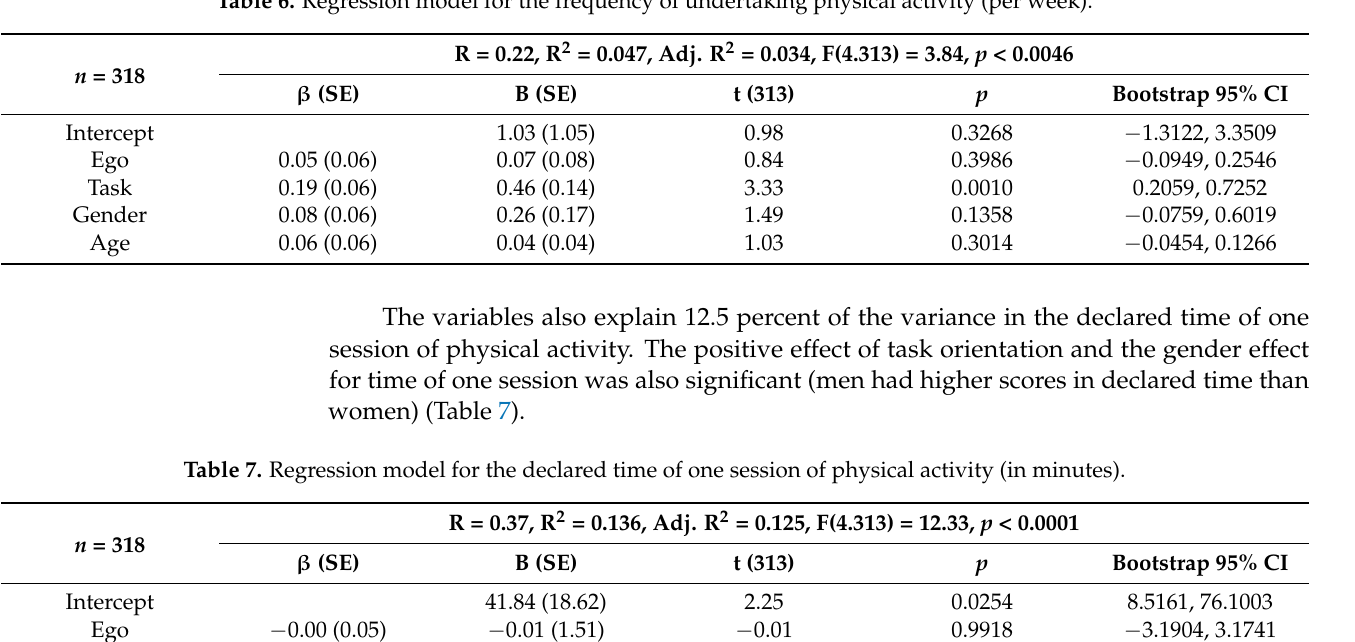
Table 6. Regression model for the frequency of undertaking physical activity (per week).